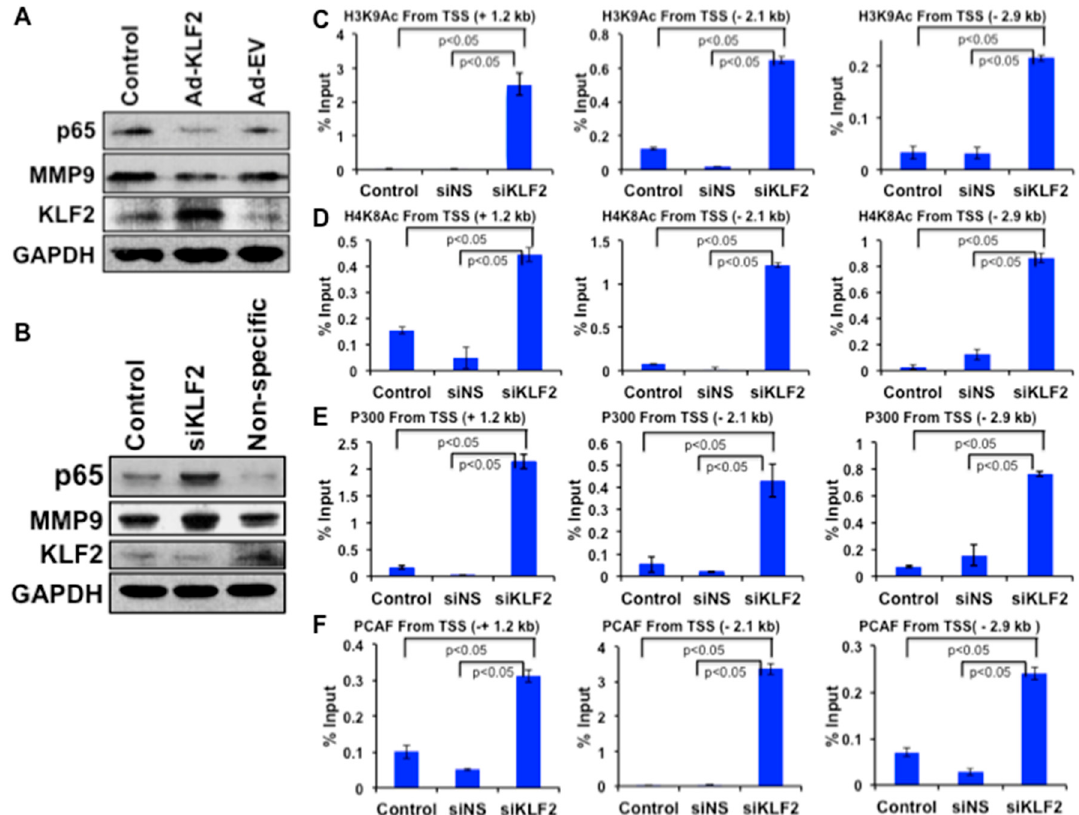
Figure 7. KLF2 inversely regulates MMP9 level, and KLF2 deficiency enriched active histone marks around transcriptional start site (TSS) of MMP9 in monocytes. ( A ) Western blot analysis of proteins after KLF2 overexpression. ( B ) Western blot analysis of proteins after KLF2 Knockdown. ChIP-RT-PCR analysis of histone acetylation marks and acetyltransferases on the promoter region of MMP9 using three di ff erent TSSs in monocytes after knockdown of KLF2 (siKLF2), non-specific knockdown (siNS) and control. ( C ) ChIP-RT-PCR analysis of H3K9Ac. ( D ) ChIP-RT-PCR analysis of H4K8Ac. ( E ) ChIP-RT-PCR analysis of p300. ( F ) ChIP-RT-PCR analysis of PCAF. Graphical results are means ± SEM from at least three independent experiments with